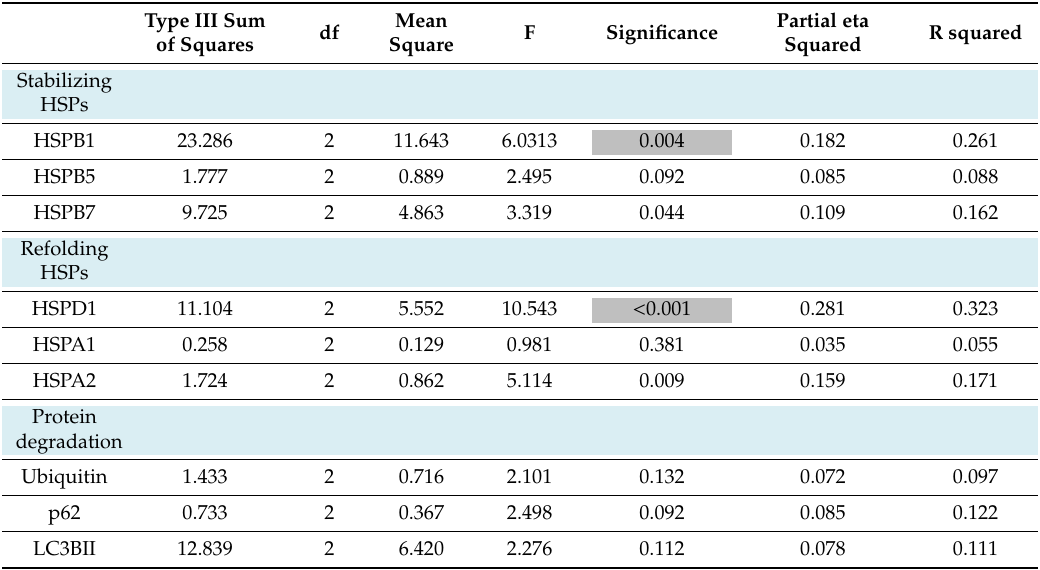
Table 4. Tests for between-subjects: HCM grouping (controls, HCM SMP , HCM SMN ) as an e ff ect and correction for di ff erences in sex and age at